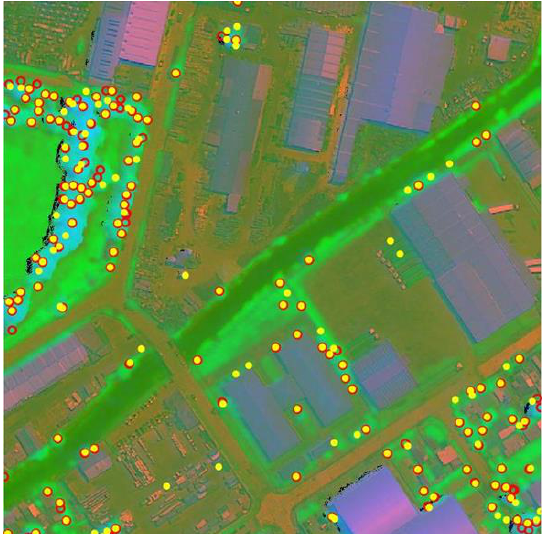
Figure 8. The treetop detection result of the town area. The yellow dots are the treetops detected by FCN and the red circles are the treetops detected by THR operation.